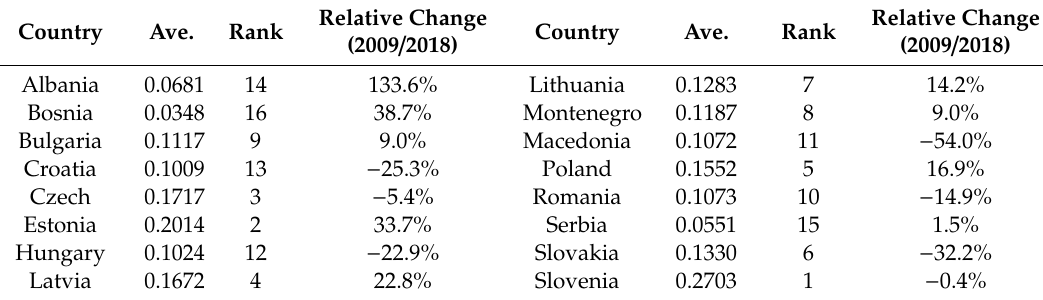
Table 7. Average Evaluation results of economic climate in CEE